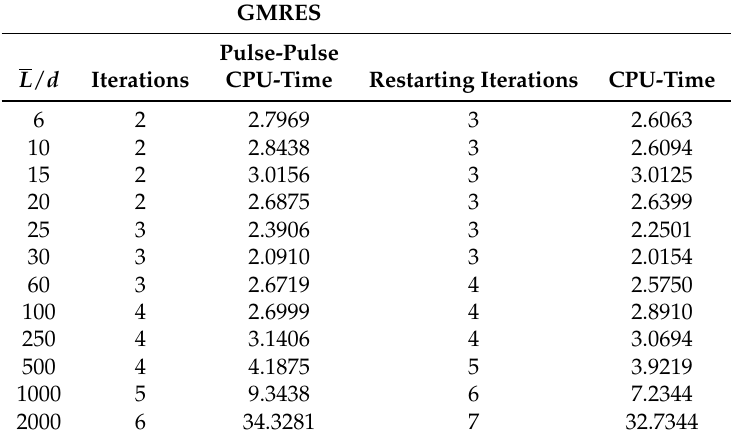
Table 3. GMRES: CPU-time (s) and #iterations for triangular–delta basis-testing functions as L